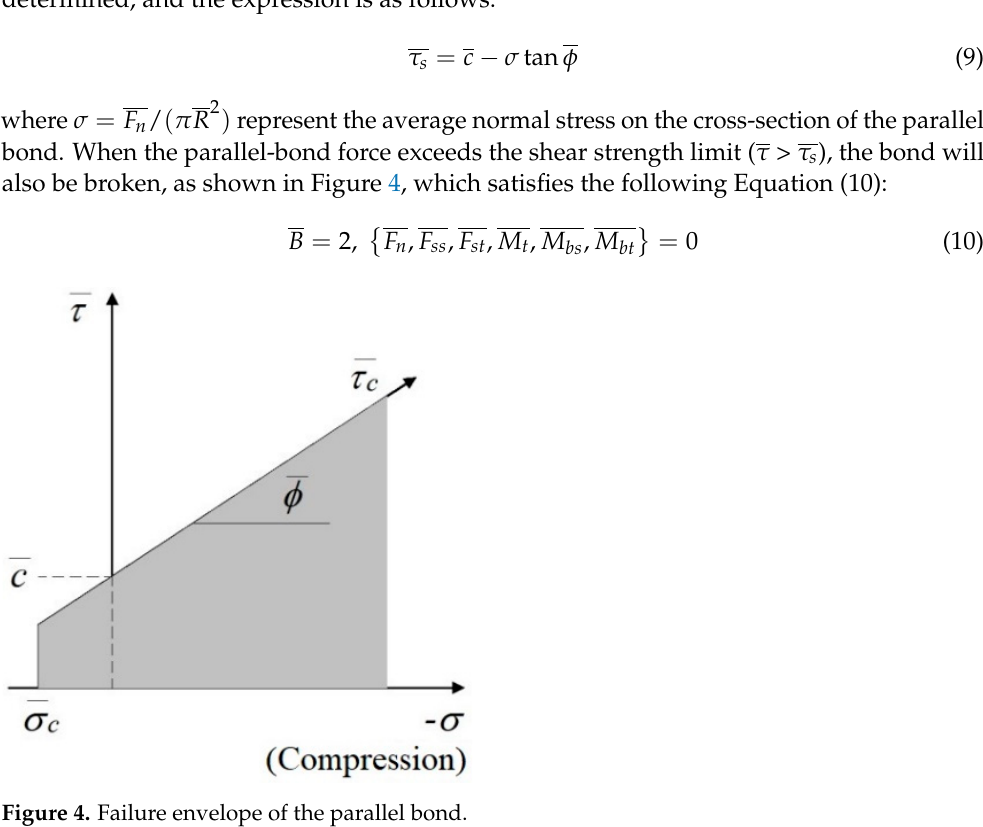
5 of 26 Figure 3. Schematic diagram of the parallel bond. The bond broken satisfies Equation (8), which is applicable when the force on the parallel bond exceeds the tensile strength limit.